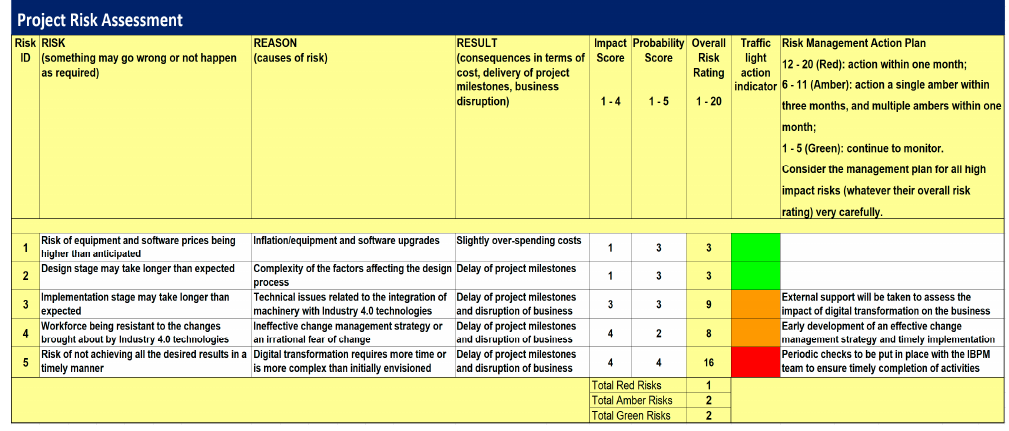
Figure 12. Sample risk assessment.